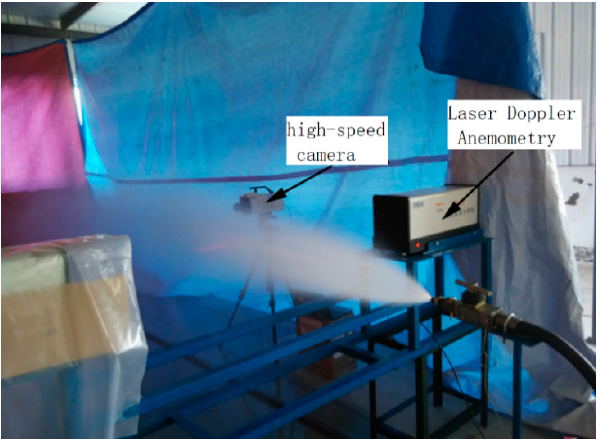
Figure 3. Setup and testing of the swirl nozzle.